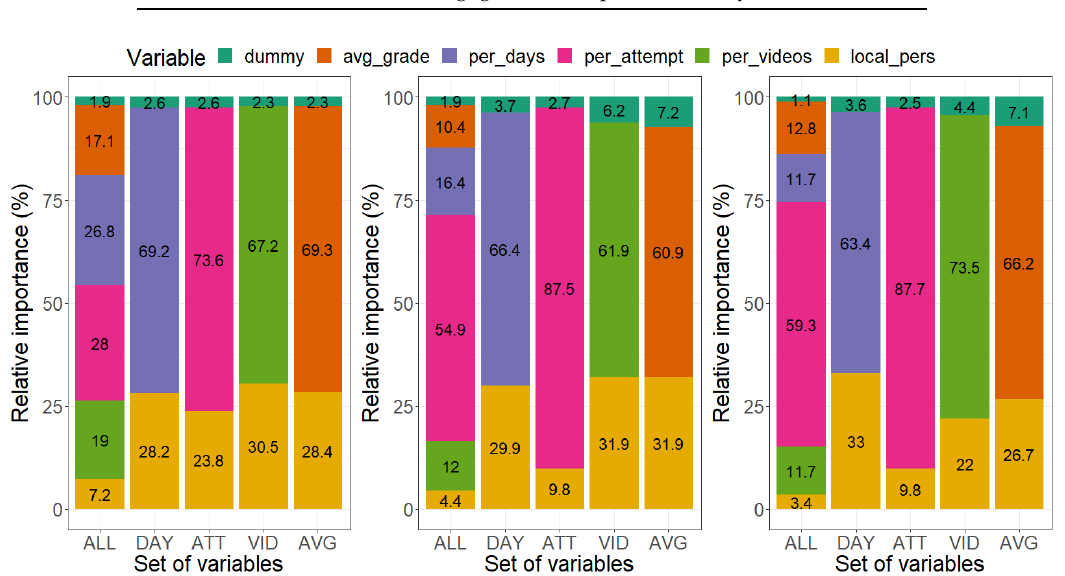
Figure 8. Relative importance of variables when predicting ( a: left ) dropout related to activity, ( b: middle ) dropout related to completion and ( c: right ) success using different combinations of variables. Table 5. Models used in the predictive analysis.